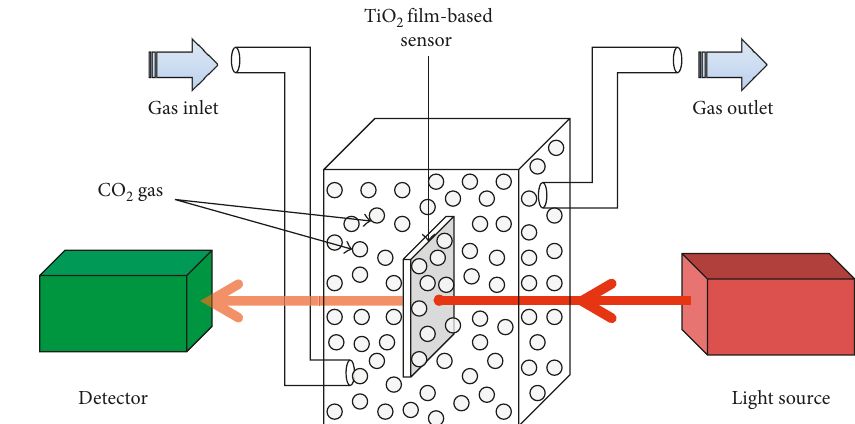
Figure 2: Experimental setup for CO